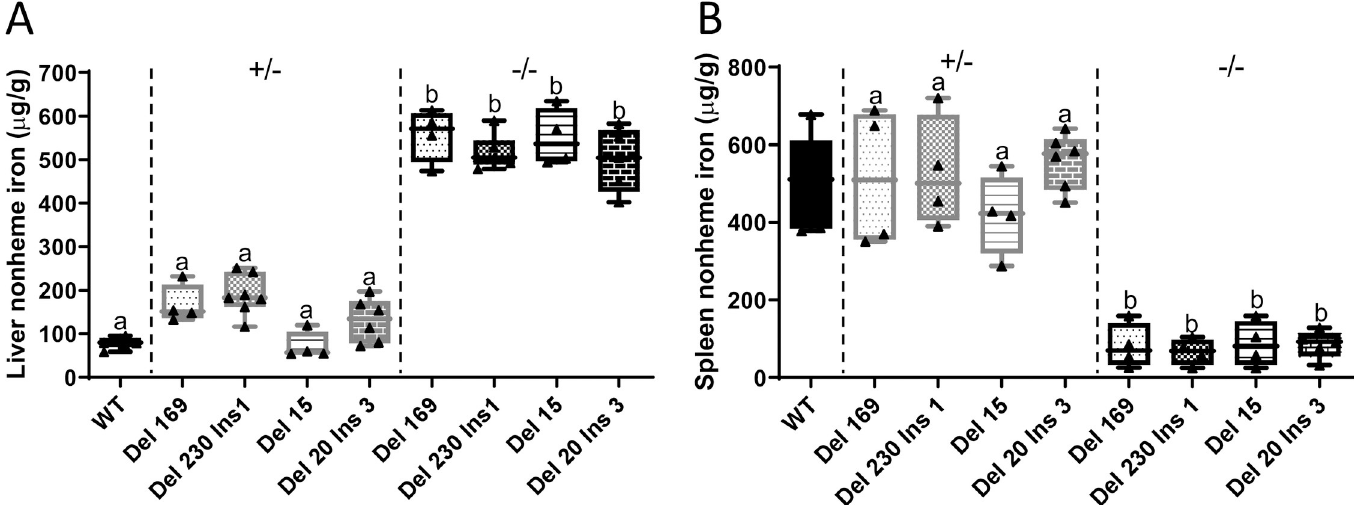
Fig 2. Homozygosity for four different Hamp mutations leads to hepatic iron loading and splenic iron depletion. Hepatic ( A ) and splenic ( B ) nonheme iron concentrations were determined in tissues derived from male WT (as a control), Hamp +/- and Hamp -/- rats at 8–9 weeks of age. Data are presented as box plots for n = 4–6 rats/group. Data were log-transformed to obtain equal variances and subsequently analyzed by one-way ANOVA followed by Tukey’s multiple comparisons test; however, untransformed data are presented for ease of interpretation. Groups labeled with different letters vary significantly ( p � 0.0129 for data shown in panel A ; p < 0.0001 for panel B ). Del, deletion; Ins, insertion; numbers indicate how many base pairs were deleted or inserted.